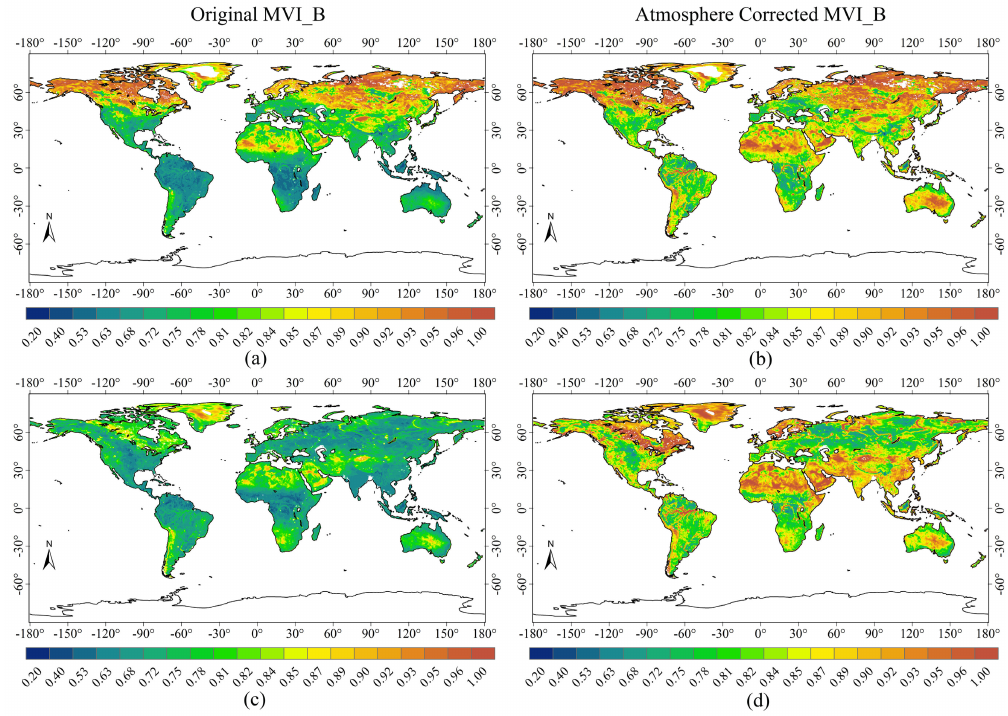
Figure 8. Comparison between MVI _ B ( X , Ku ) ∗ (original MVI_B ) and MVI _ B ( X , Ku ) (atmosphere corrected MVI_B ) on a spatial scale; ( a ) Seasonal average of original MVI_B in the months of December, January and February (DJF); ( b ) Seasonal average of MVI_B after atmospheric correction in the months of DJF; ( c ) Seasonal average of original MVI_B in the month of June, July and August (JJA); ( d ) Seasonal average of MVI_B after atmospheric correction in the months of